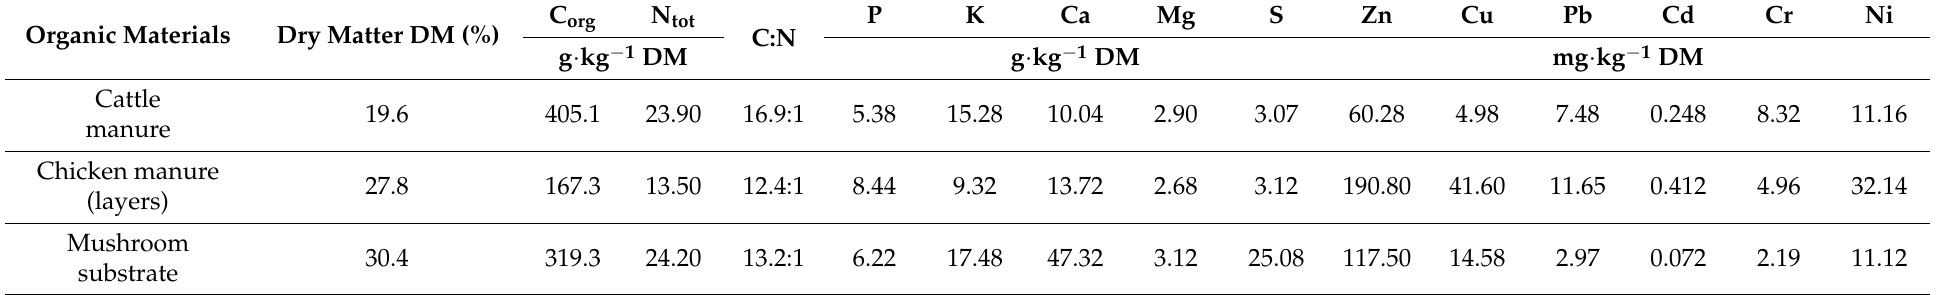
Table 1. Chemical composition of organic materials used in pot